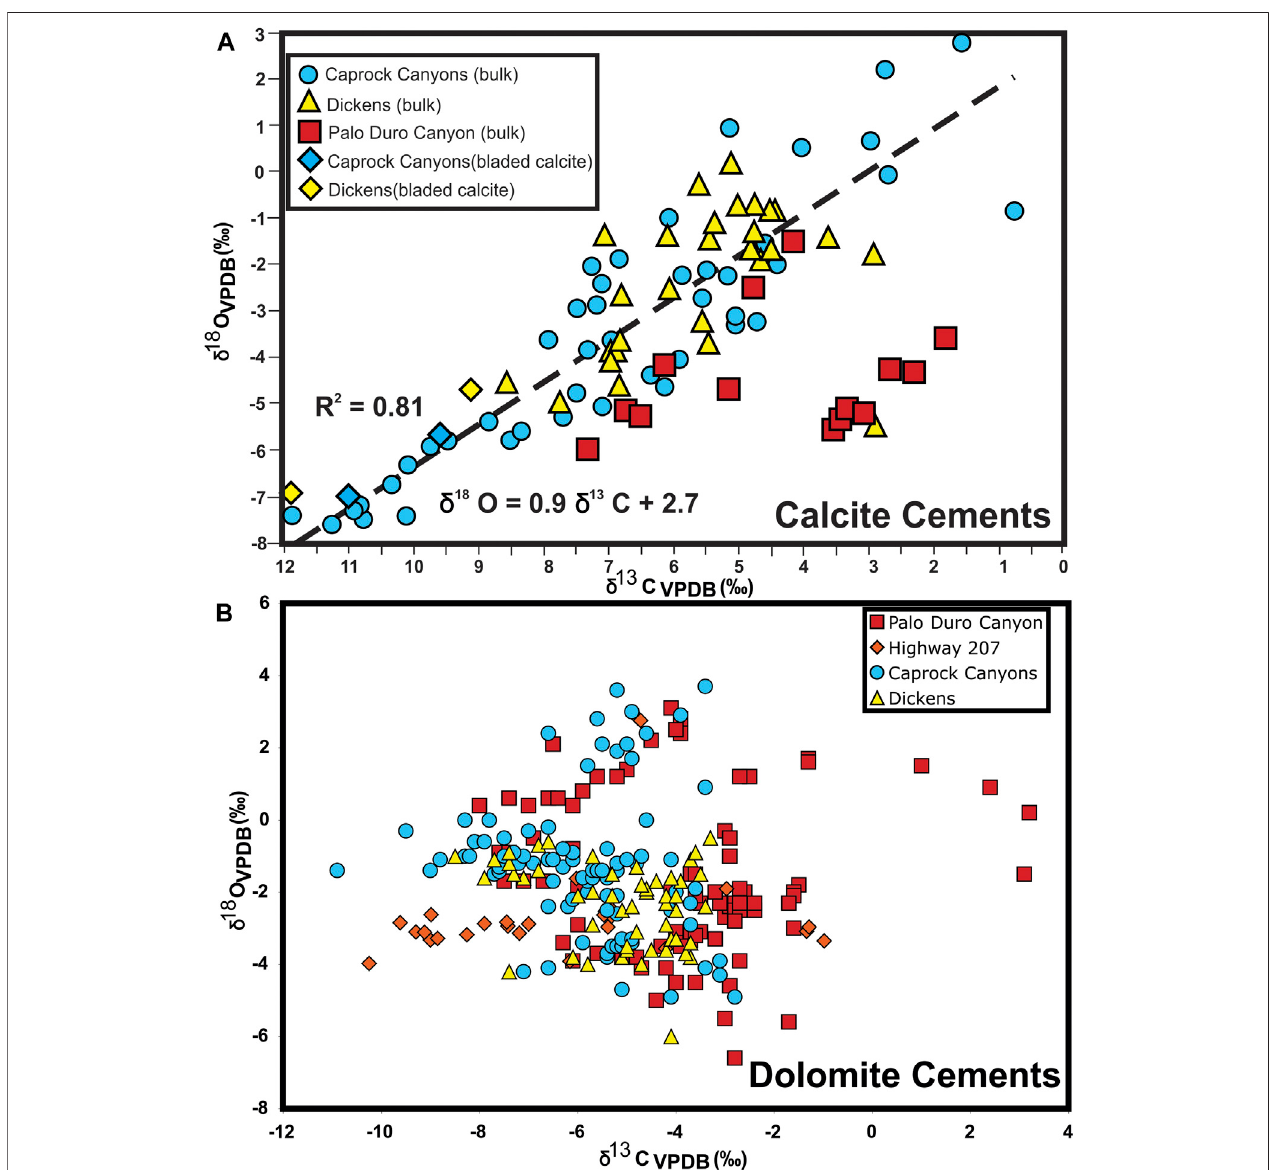
FIGURE 10 | (A) Cross plot of δ 18 O and δ 13 C values of calcite cements in bulk sediments among the three stratigraphic sections which include calcite cement as well diagenetic bladed calcite cements from the Caprock Canyons and Dickens stratigraphic sections. The strong parametric correlation seen within each, and among all,section(s)suggeststhatthemeasured δ 18 Oand δ 13 Cvaluere fl ectsamass-dependentcontributionofonepopulationofrelatively 18 O-and 13 C-richearlycementand a relatively 16 O- and 12 C-rich later diagenetic cement. See text for further discussion. (B) Cross plot of δ 18 O and δ 13 C values of dolomicrite cements in bulk sediments among the four stratigraphic sections. The lack of strong parametric correlation among these samples suggests that there is no mass-based contribution of different generations of dolomite cement with different end-member δ 18 O and δ 13 C values and therefore may represent primary or very early burial conditions during Permian-Triassic time. See text for further discussion.